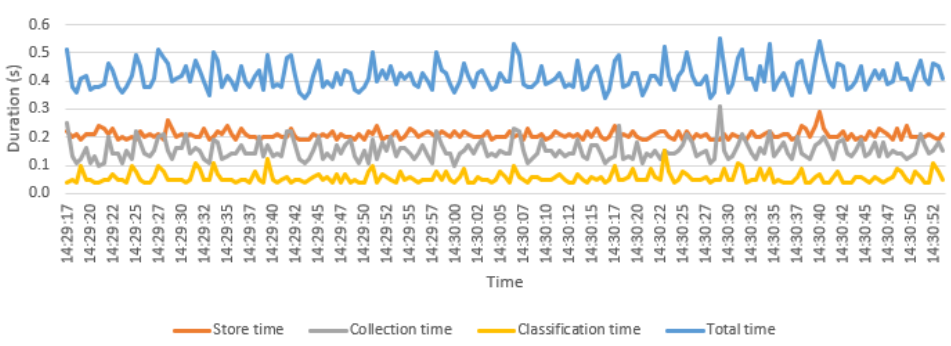
Figure 30. Processing time for sleep